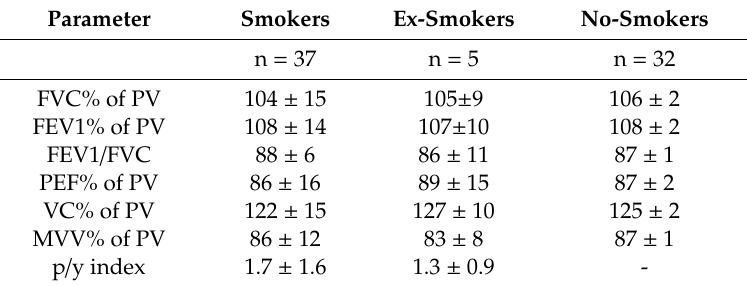
Table 4. Pulmonary function test (mean ± SD) in studied group a ff ected by smoking habits. Parameter